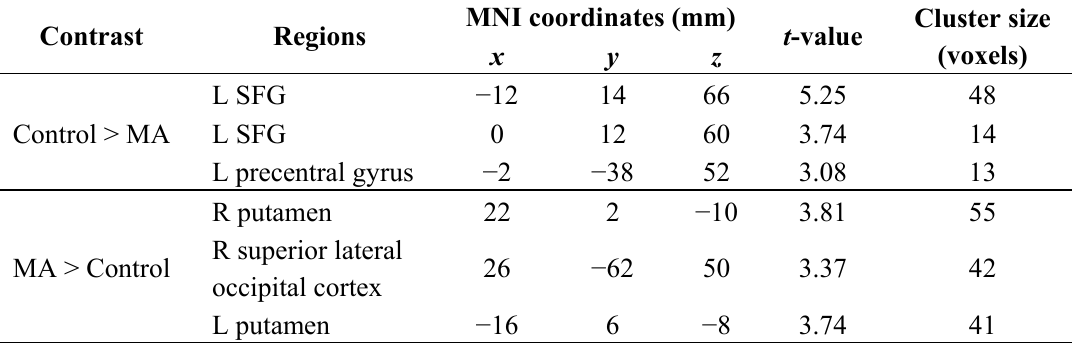
Table 2. Regions of significance ( p FSL-VBM results.